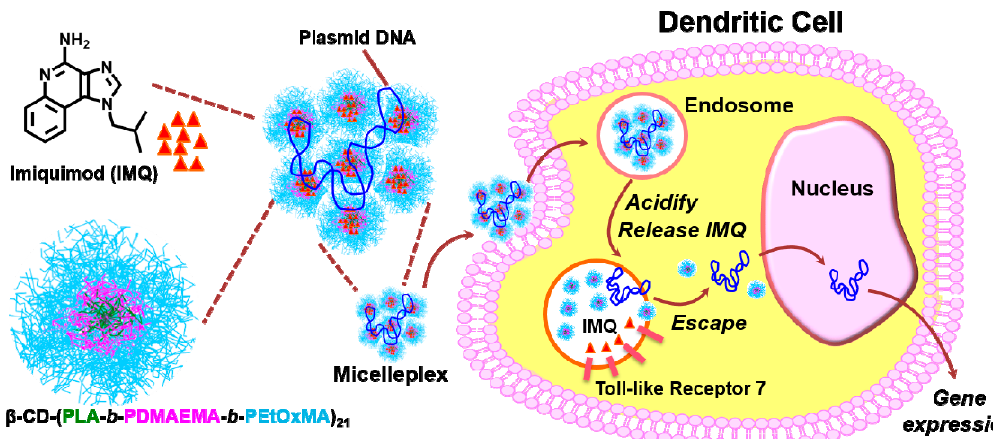
Scheme 1. Schematic illustration of co-delivery of IMQ (red triangles) and plasmid DNA to dendritic cells via unimolecular micelles formed by the amphiphilic pH-responsive star polymer β -CD-(PLA- b -PDMAEMA- b -PEtOxMA) 21 .